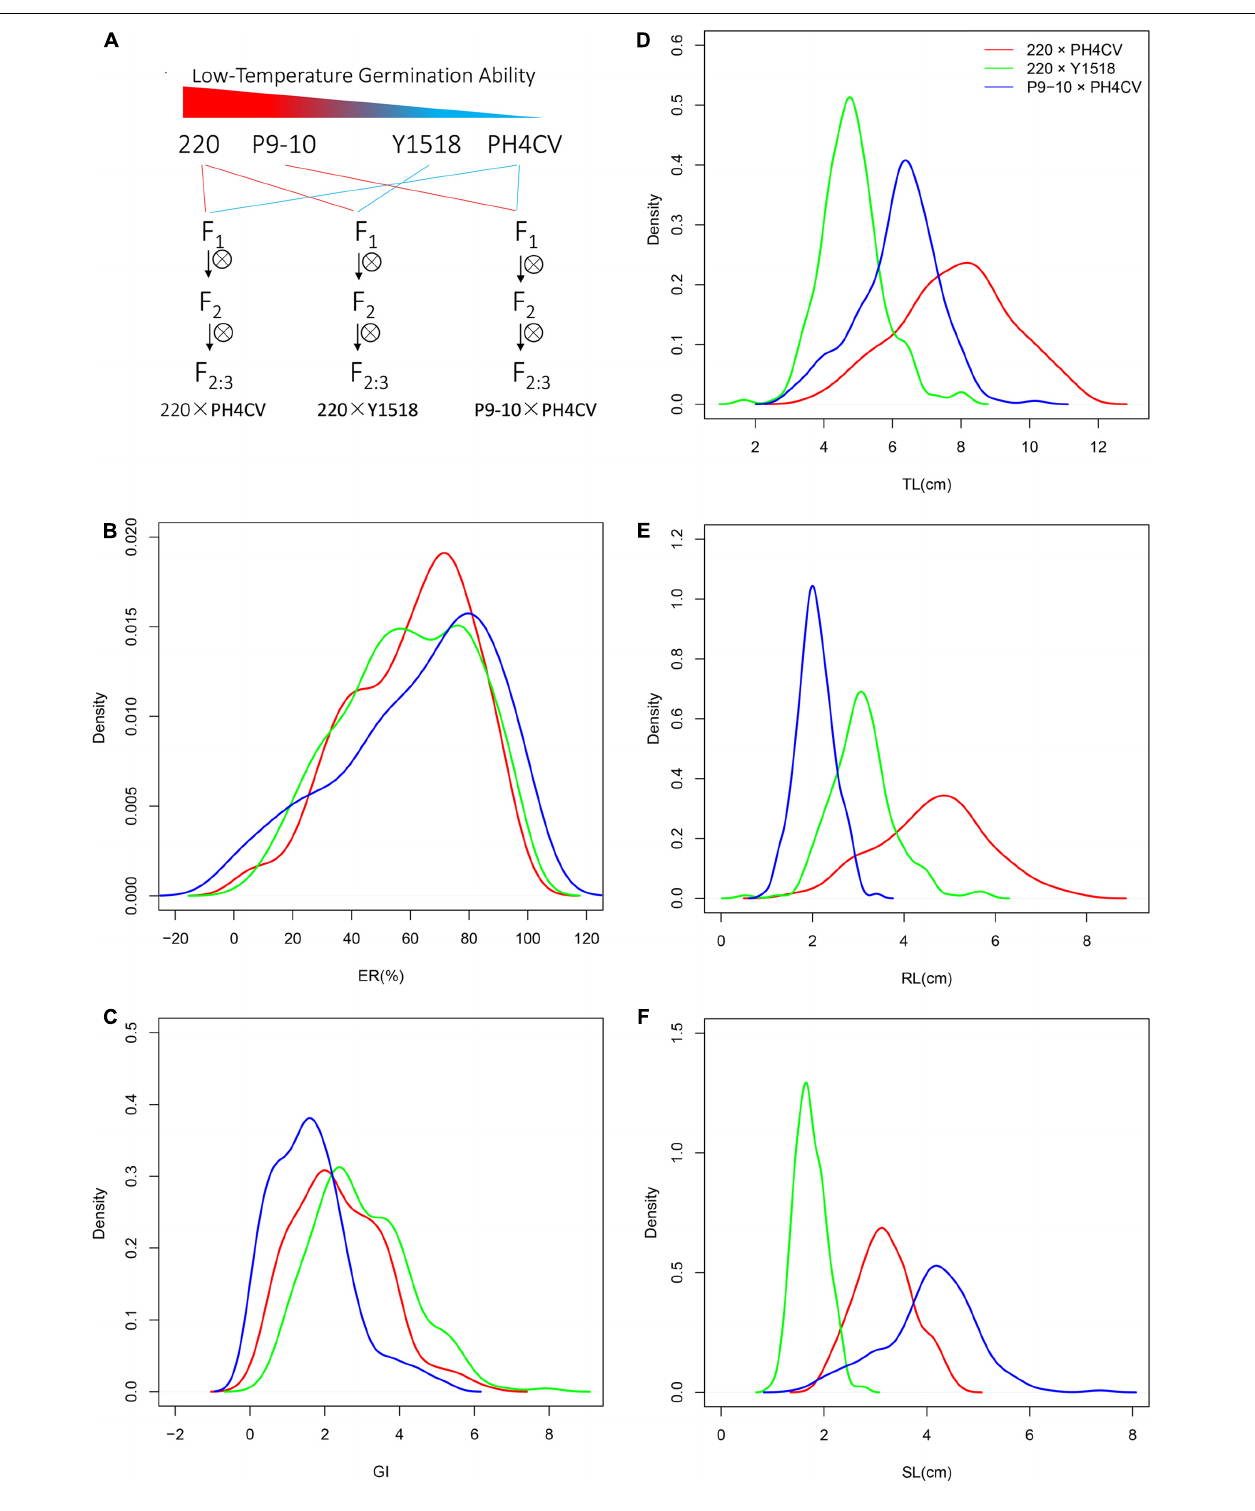
FIGURE 1 | The density of frequency distribution of cold germination related traits in populations. (A) Strategy for constructing the three connected populations 220 × PH4CV, 220 × Y1518, and P9-10 × PH4CV. Traits emergence rate (ER, B ) and germination index (GI, C ) were collected from sand bed experiment, and total length (TL, D ), root length (RL, E ) and shoot length (SL, F ) were collected from paper rolls experiment. Line in red, green, and blue represented trait performance in population 220 × PH4CV, 220 × Y1518, and P9-10 × PH4CV, respectively.